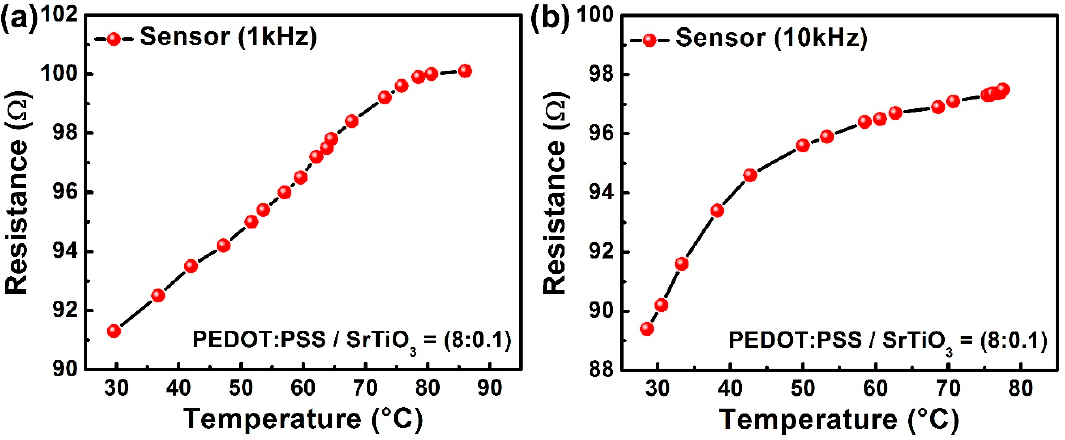
Figure 6. ( a , b ) Impedance versus temperature at 1 kHz and 10